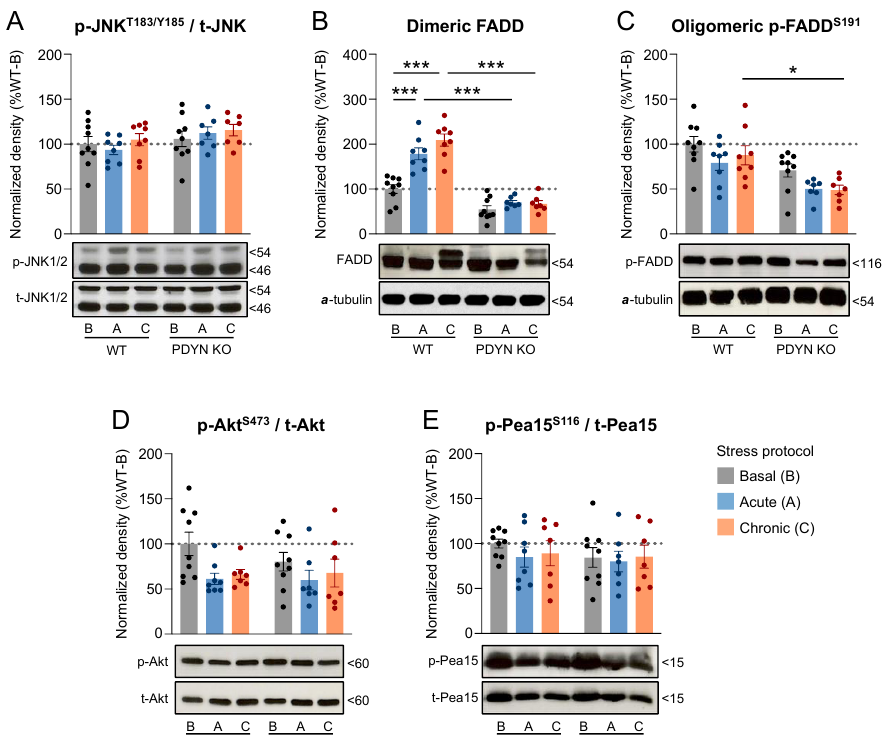
Figure 5. Thalamic immunodensities of ( A ) activated p-Thr183/Tyr185 JNK1/2, ( B ) dimeric FADD, ( C ) oligomeric p-Ser191 FADD, ( D ) activated p-Ser473 Akt, and ( E ) p-Ser116 Pea15 in WT and PDYN-KO mice exposed to acute restraint (A, blue bars) or chronic mild (C, orange bars) stress procedures, as compared to basal (B, grey bars) stress levels in undisturbed animals. Normalized protein amounts were estimated as the ratio between the corresponding immunoreactive band to total enzyme or α -tubulin. Columns are means ± SEM of n = 7 – 9 mice per experimental group and expressed in percent change from wildtype-basal (WT-B) mice. All datasets were analyzed by TW- ANOVA (see Table 1). * p < 0.05, and *** p < 0.001, TW- ANOVA followed by Tukey’s post hoc test. ( A – E ) Representative immunoblots of phosphorylated and/or non-phosphorylated species of the indicated proteins are shown at the bottom. The indicated molecular weights (in kDaltons, kDa) of the immunoreactive bands were estimated from in-gel-loaded, prestained protein standards.